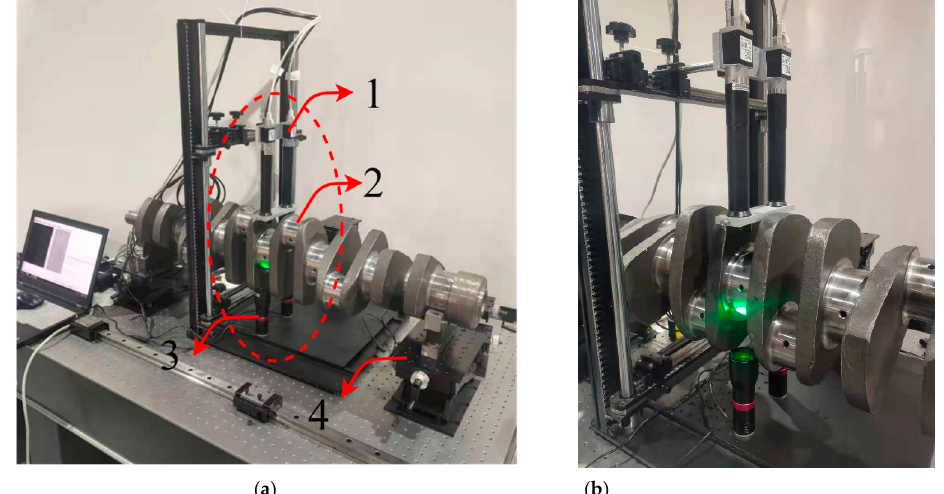
Figure 15. Measurement platform: (1) Dual camera system; (2) crankshaft; (3) parallel light sources; (4) adjustable V-lock. ( a ) Overall display image of platform. ( b ) Partial display image of platform.